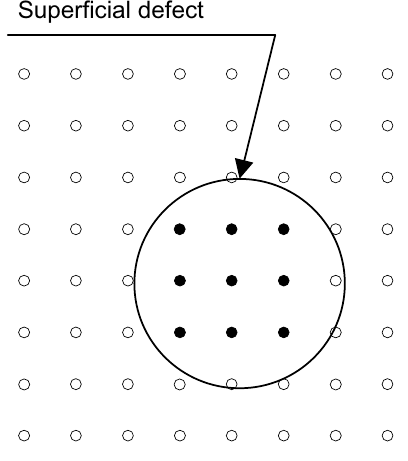
Fig. 11. ANN output related to an high resolution grid measured on the aluminium